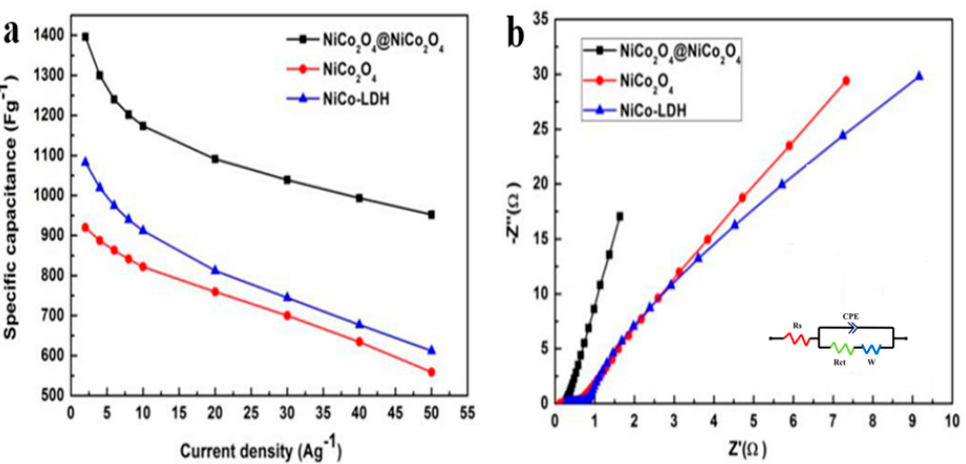
Figure 6. ( a ) Specific capacitances of different samples at different CDs and ( b ) Nyquist curves of different samples.